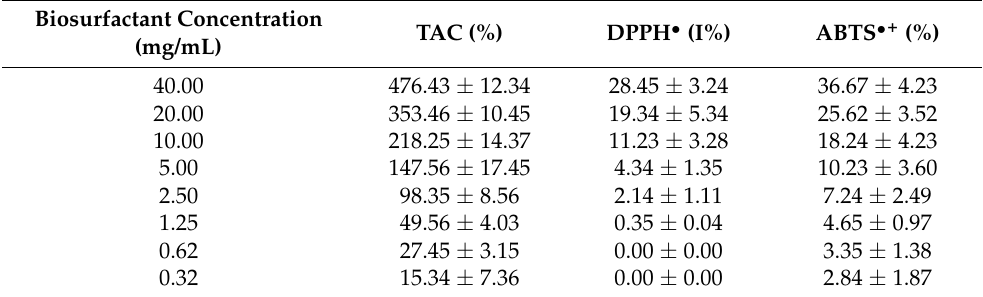
Table 3. Total antioxidant capacity (TAC) and oxidative inhibition based on the DPPH • and ABTS • + scavenging capacity of the biosurfactant produced by Bacillus cereus UCP 1615 at different